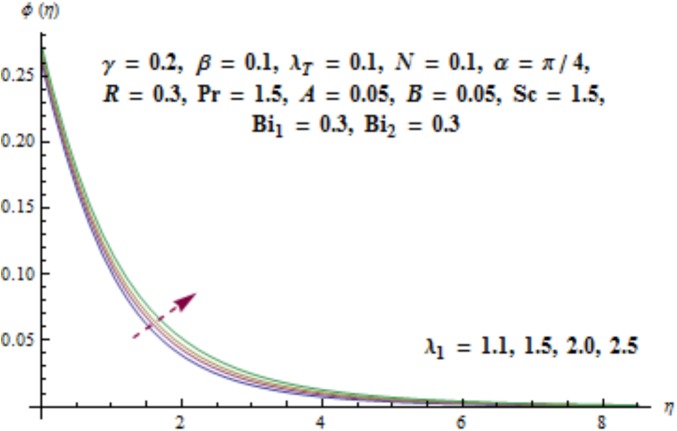
Behavior of λ1 on ϕ(η).